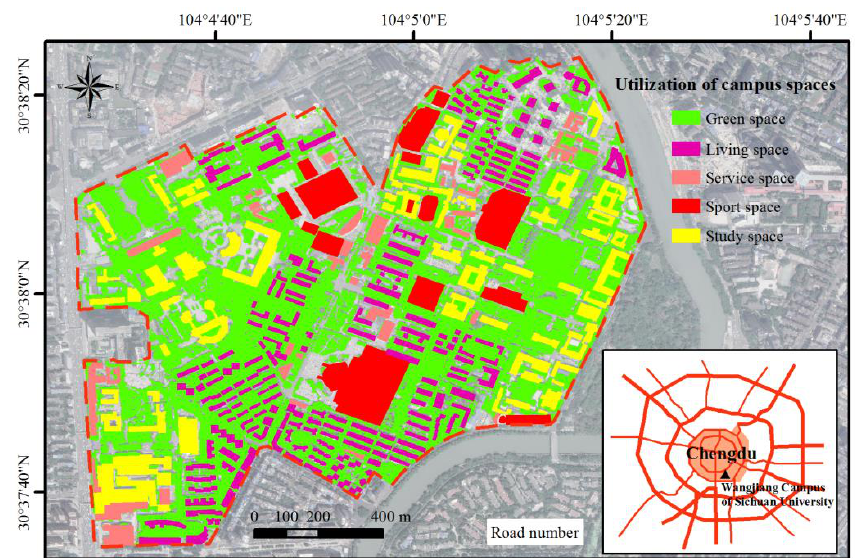
Figure 10. Utilization of campus spaces.